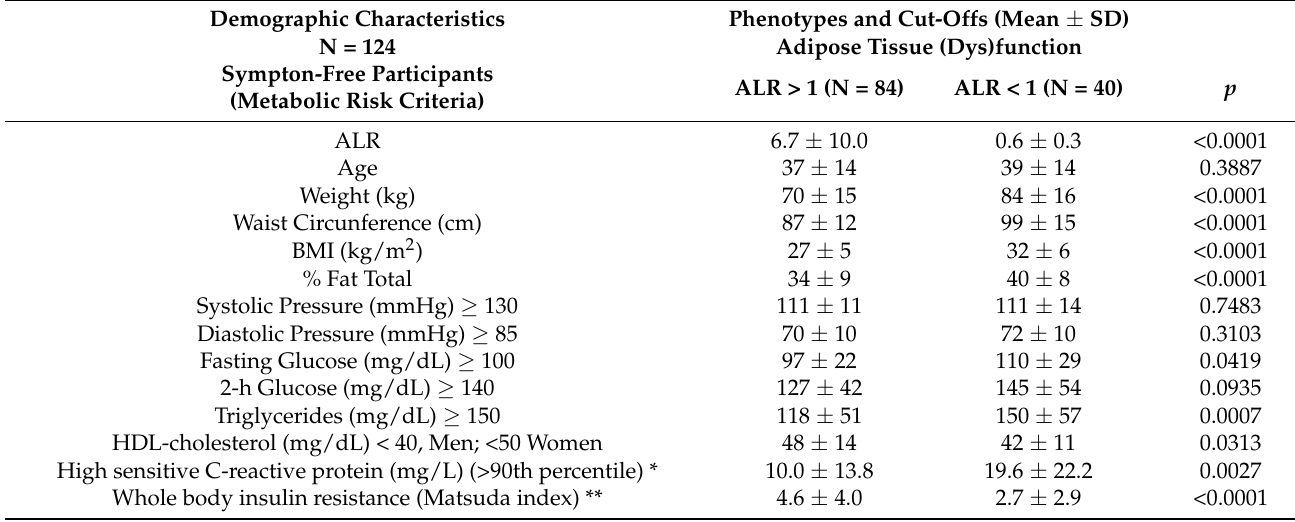
Table 1. Demographic characteristics and clinical parameters for the adipose tissue dysfunction phenotype in our symptom- free GEMM